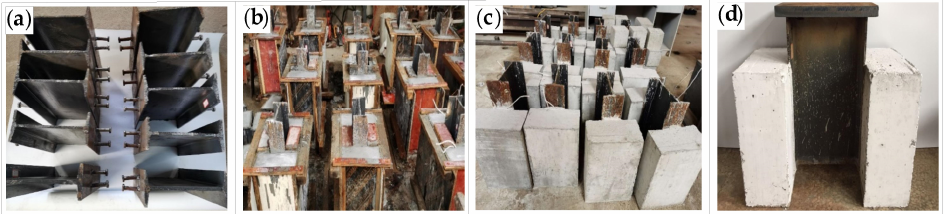
Figure 2. Fabrication of push-out specimen: ( a ) welding studs; ( b ) concrete pouring; ( c ) concrete curing; ( d ) welding steel plates.